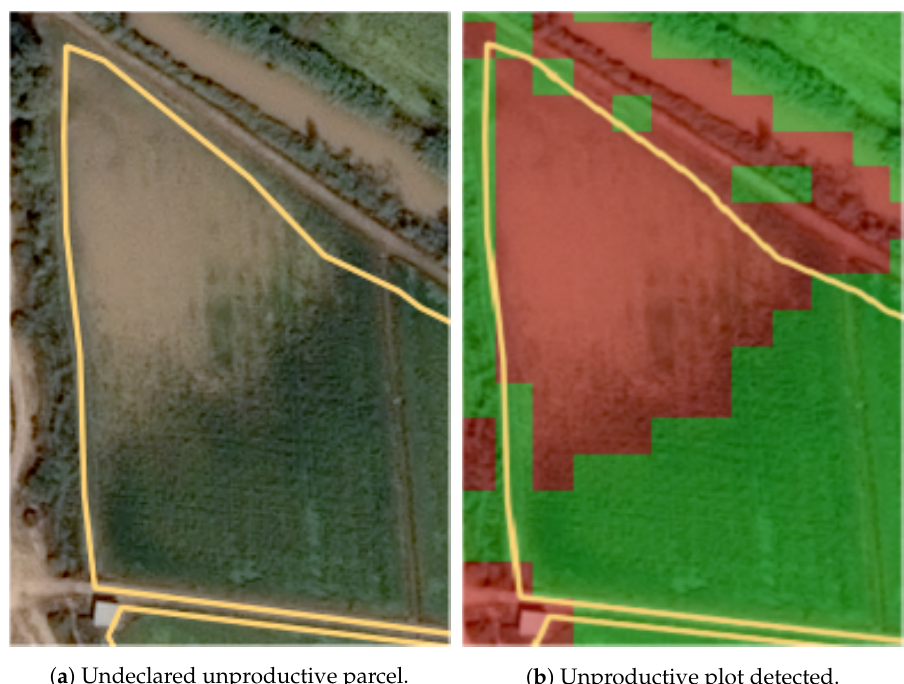
Figure 22. Example of unproductive detection through ML.